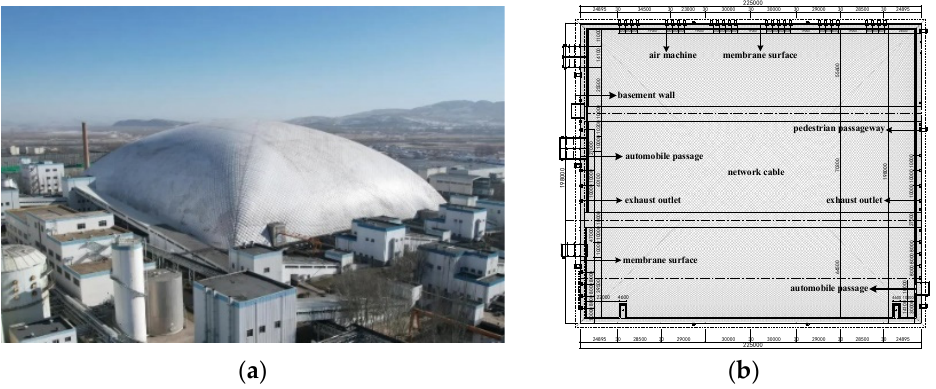
Figure 1. Closed coal yard structure. ( a ) Aerial View; ( b ) Structure Plan View.